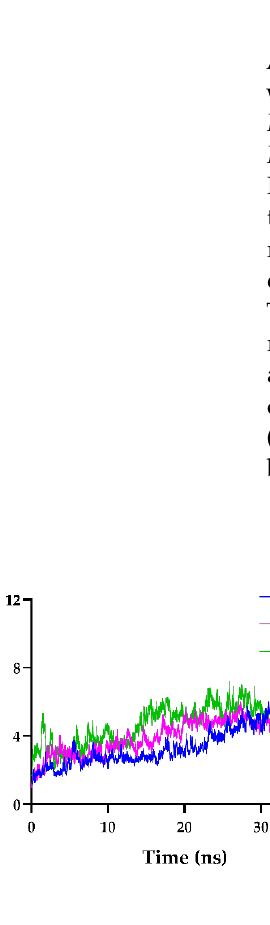
Figure 6. Three FMD simulations of the Mut complex. ( A ) Variation of Cα -RMSD with time for Mut1 (blue), Mut2 (magenta), and Mut3 (green) . The Cα -RMSD fluctuated in a range of 1 Å when the time exceeded 20 ns. ( B ) Frequencies of the N HB for three Mut complexes. The N HB of the Mut1, Mut2 and Mut3 were fitted by Gaussian distribution (R 2 > 0.98). ( C ) The heat maps of the average survival ratios of H-bonds on the interface of the Mut complex. Table 7. The H-bonds on the interface of the Mut complex with an average survival ratio >10%. Survival Ratio Ranking TSP8 Spacer